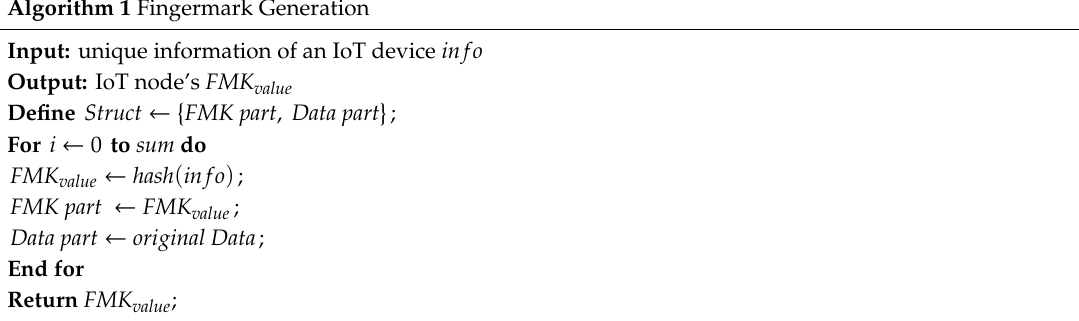
Figure 5. The sequence diagram of the architectural algorithm.